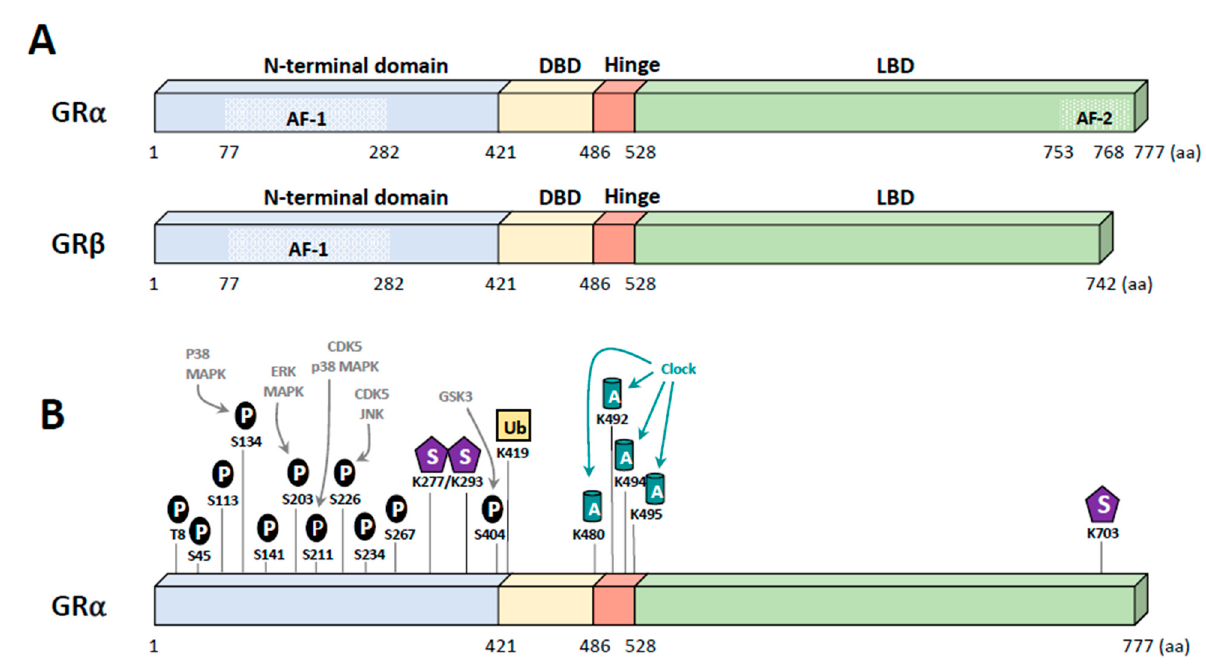
Figure 1. Structure of human glucocorticoid receptor (GR). ( A ) Alternative splicing of exon 9 results in two isoforms of GR; GR α and GR β . GR contains different domains: the N-terminal domain (NTD), DNA binding domain (DBD), the flexible Hinge region and the ligand binding domain (LBD). GR encompasses two activation functions (AF-1 and AF-2) allowing the recruitment of coregulators and the transcriptional machinery. ( B ) GR α undergoes numerous post-translational modifications including phosphorylation of various residues (mainly serine residues) (P), sumoylation (S), acetylation (A) and ubiquitinylation (Ub).